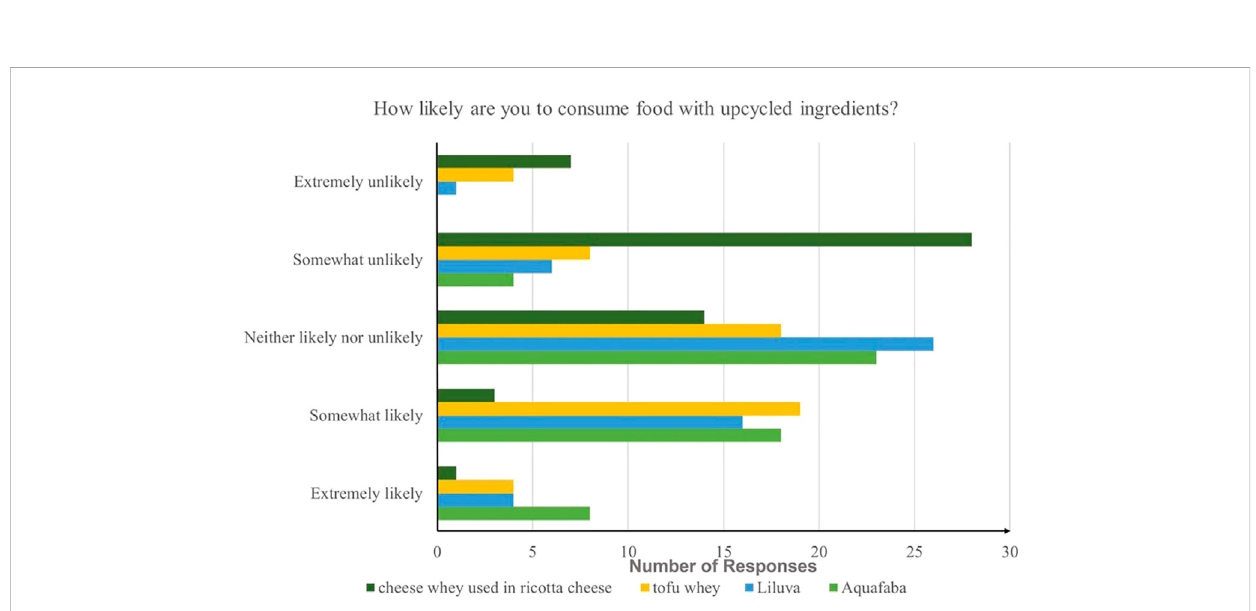
FIGURE 2 Responsefromfocusgrouppaneliststoanintentionquestion: “ Howlikelyareyoutoconsumefoodwithupcycledingredients(suchascheesewhey used in ricotta cheese, tofu whey, liluva, and aquafaba)?